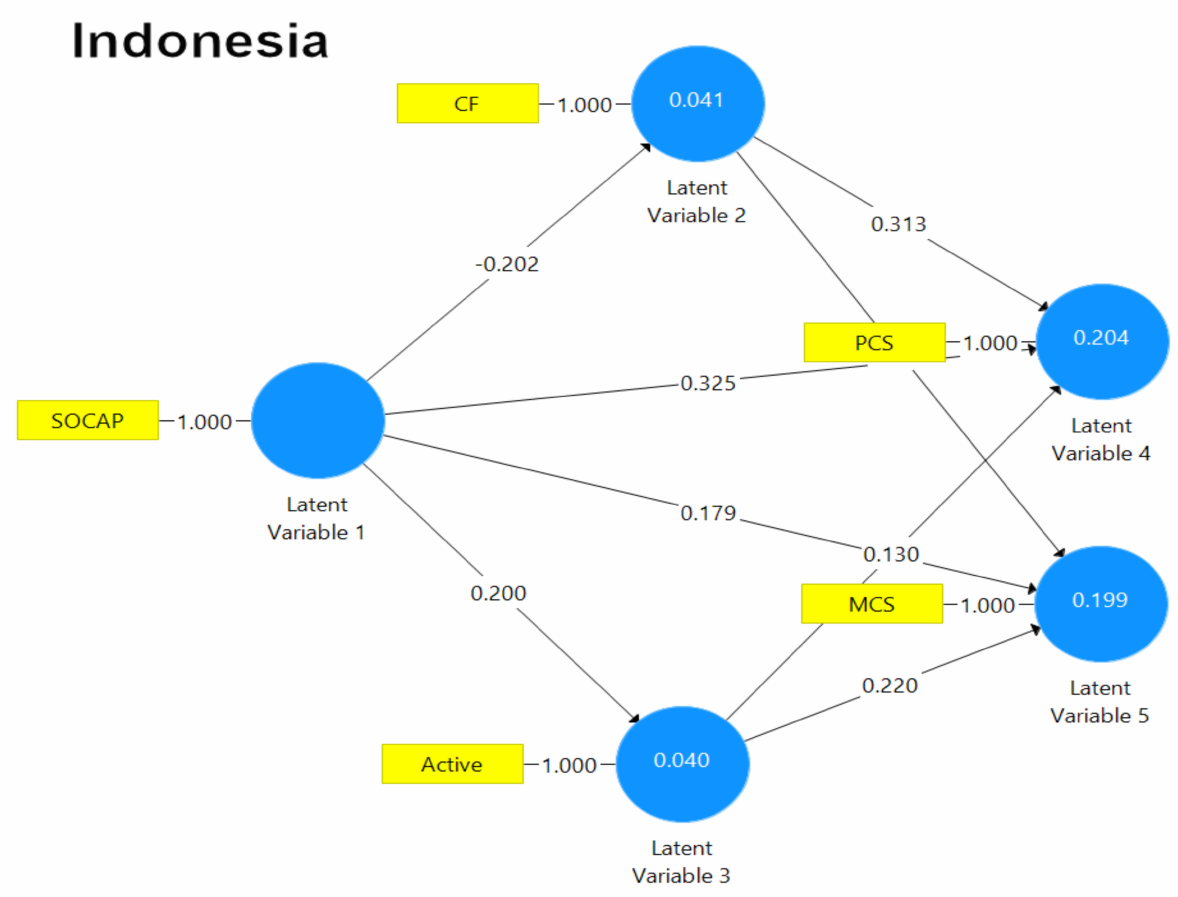
Figure 4. Diagram summarizing the path analytic findings of the Indonesian sample. [Note. Active = active coping; CF = coping flexibility; MCS = mental health composite score; PCS = physical health composite score; SOCAP = social